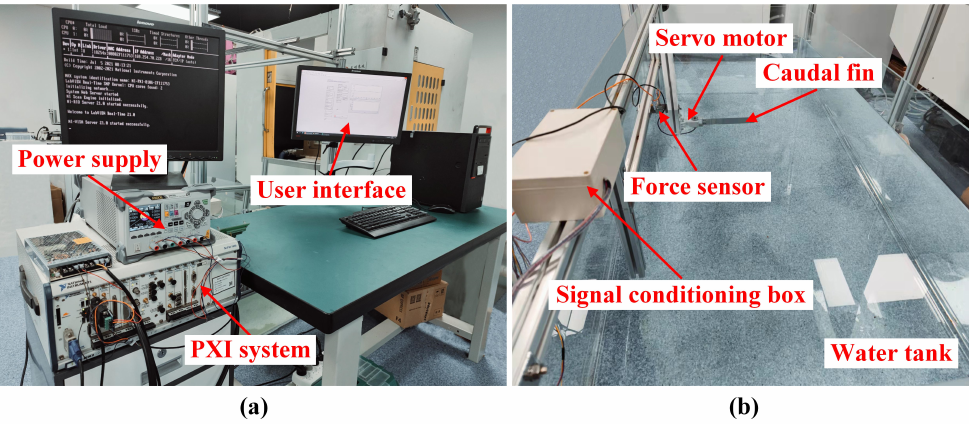
Figure 2. The experimental setup: ( a ) The motion control unit of the platform. ( b ) The foil flapping in a water tank of the size of 2000(L) × 1000(W) × 600(H)